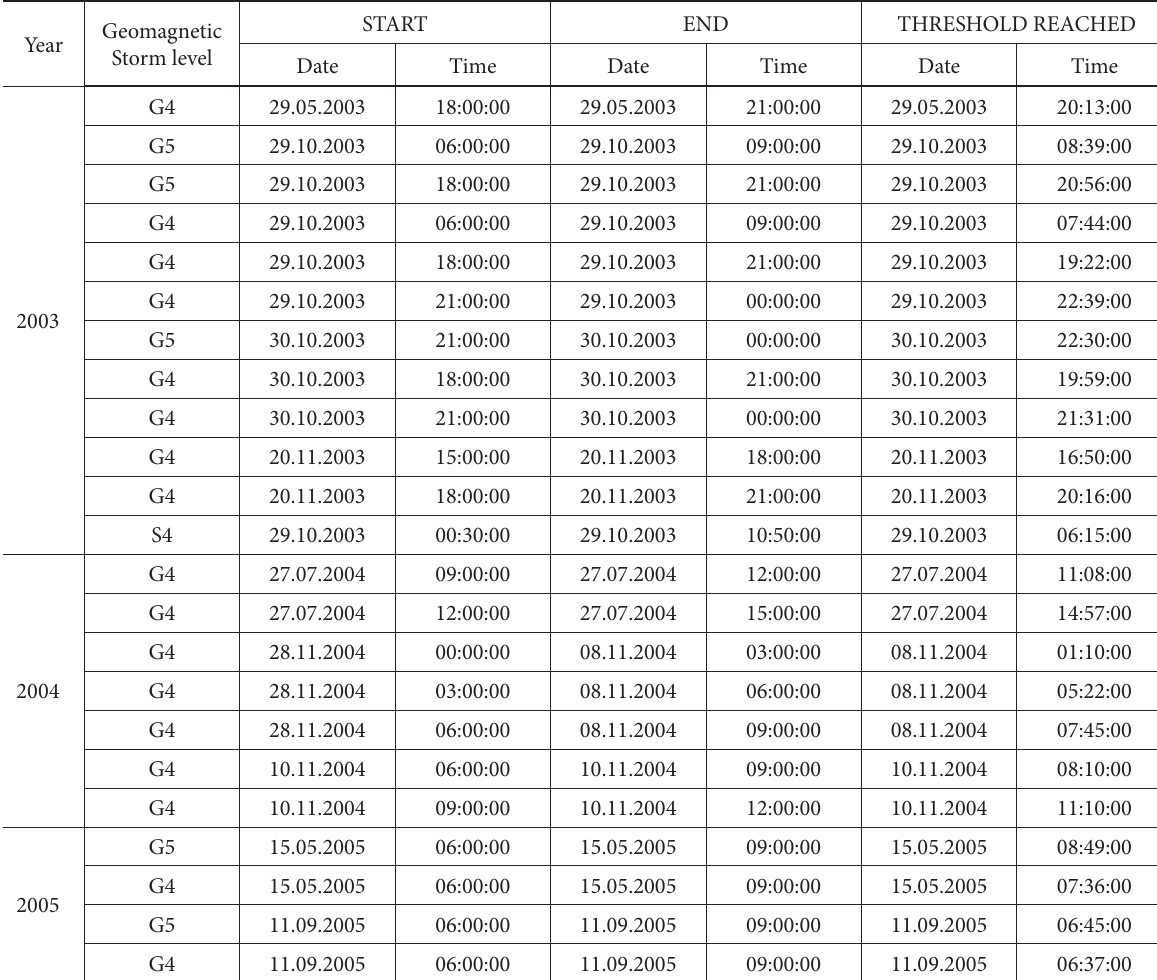
Table 2. Priority list of solar storms to be used on research experiments Geomagnetic Year Storm level